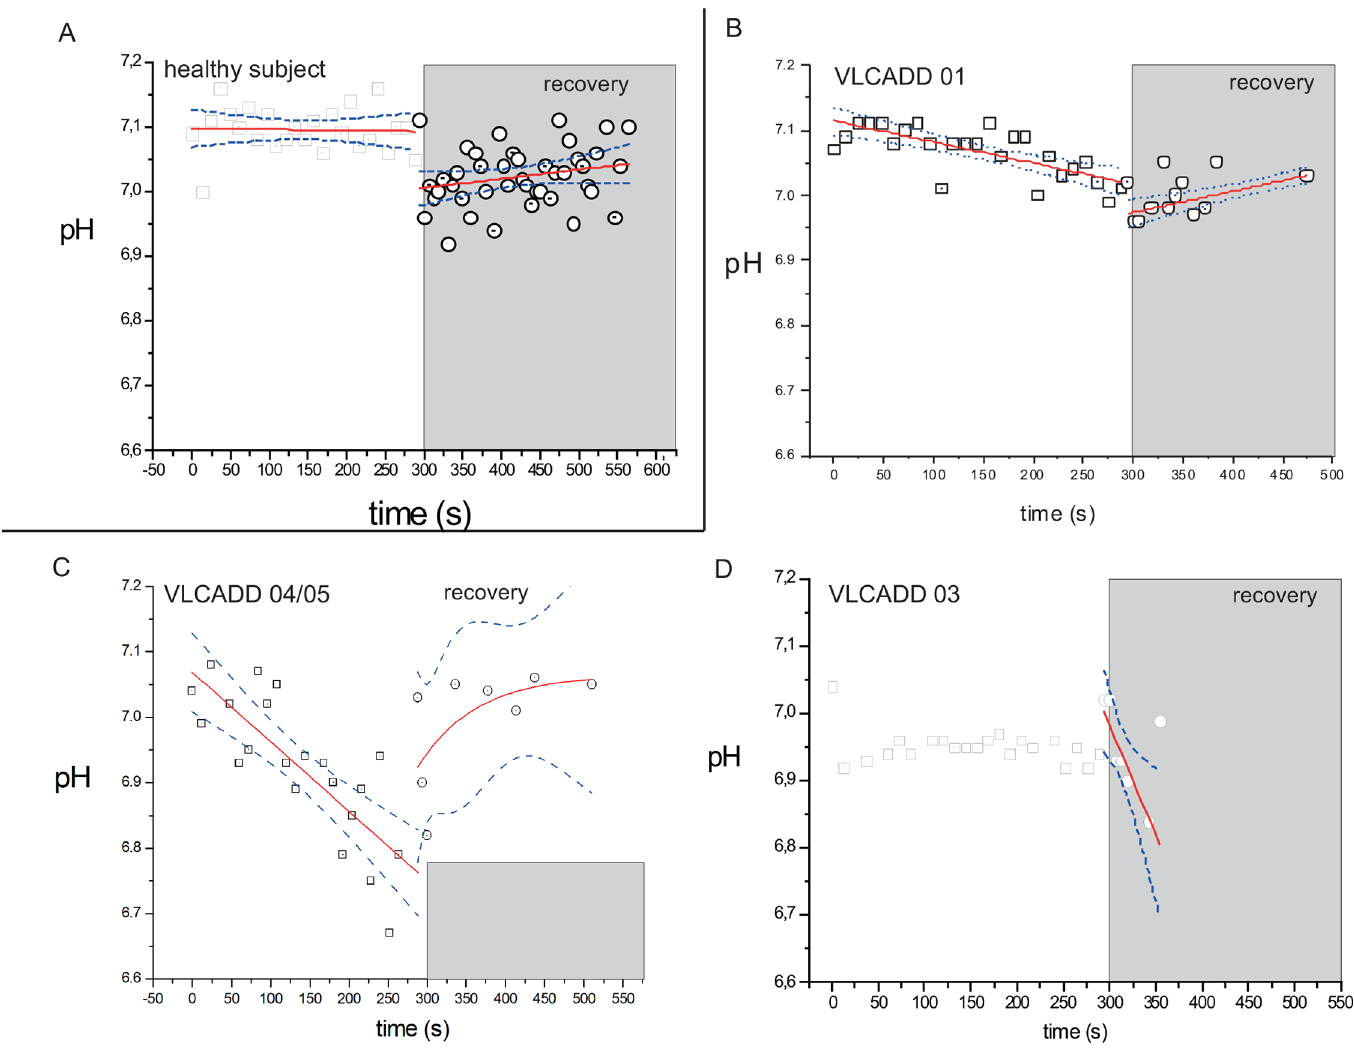
Fig 4. pH dynamics during exercise and first minutes of recovery. The error bars show the variance in the data from AMARES fitting of the MR spectra (see Methods section). (A) Healthy controls. (B-D) VLCADD patients. Solid red lines show the fit of linear or monoexponential functions to the data; blue lines show the 95% confidence interval of the fit.